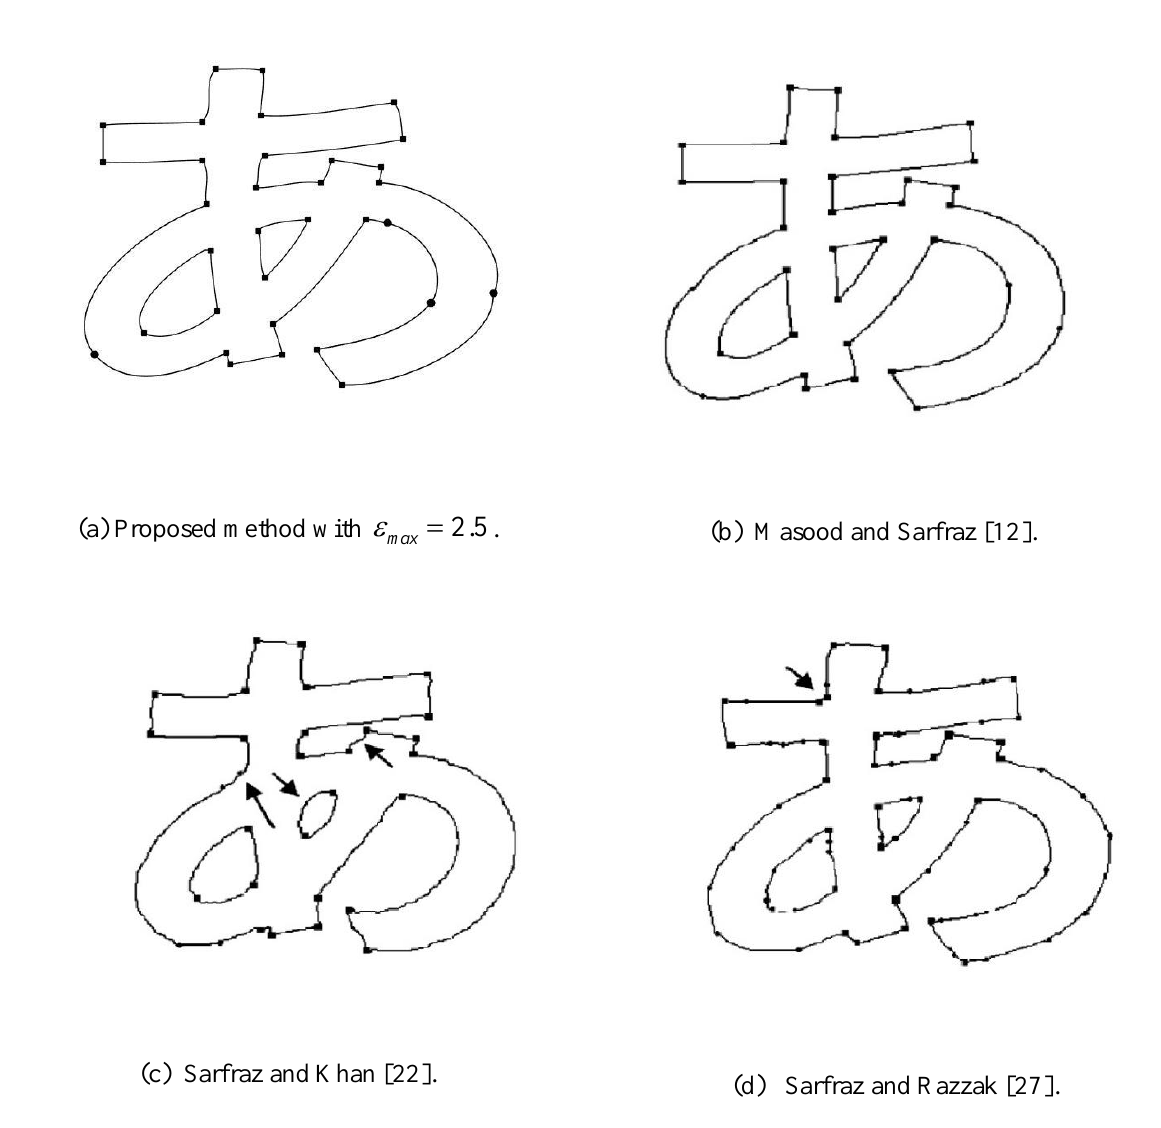
Figure 6. Captured shape of the Kanji character with different